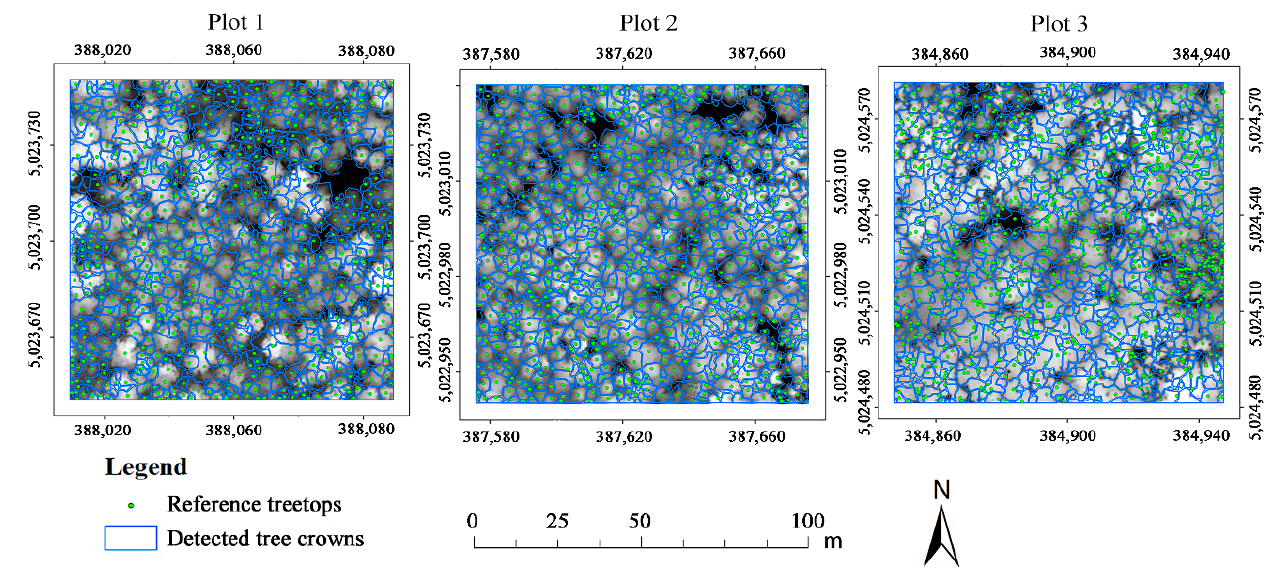
Figure 4. Maps of detected tree crowns and reference treetops in the three 100 m × 100 m sample plots. Based on the matching conditions listed in [35], PA, UA, and OA were calculated and the accuracy assessment results for the three plots are shown in Table 4. The field inventories of the three sample plots measured 2688 trees, while the RHCSA algorithm detected 2648 trees with a detection rate of 98.51% and an average match rate (including 1:1 matches and near-matches) of 72.3%. The highest match rate was obtained in Plot 2, possibly due to the presence of fewer small trees, which were suppressed by taller trees in other plots. The least accurate match rate was obtained in Plot 3, which may be due to the uneven and very dense distribution of trees in Plot